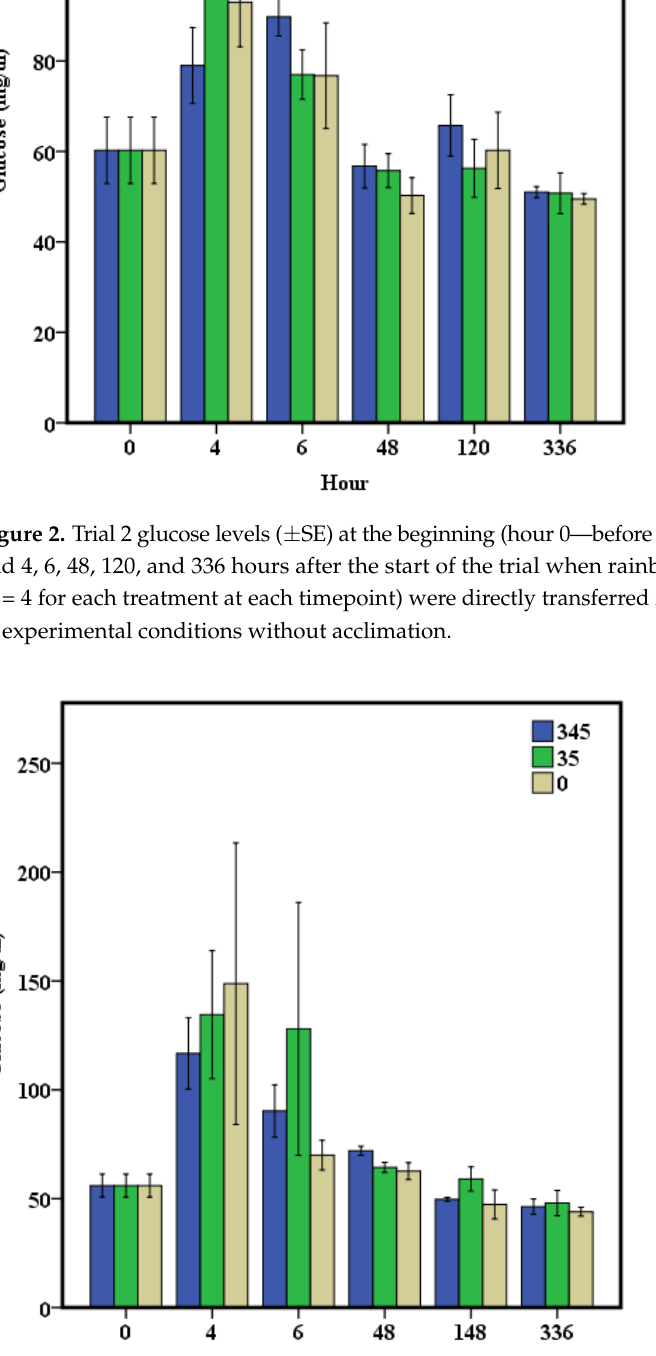
Figure 3. Trial 3 glucose levels ( ± SE) at the beginning (hour 0—before transfer, basal hardness of 345 mg/L) and 4, 6, 48, 120, and 336 hours after the start of the trial when rainbow trout Oncorhynchus mykiss ( n = 4 for each treatment at each timepoint) were directly transferred from 345 mg/L water hardness to experimental conditions without acclimation. With blood glucose in the fourth trial, there was a significant interaction between hardness and temperature for hour 48 ( p = 0.046) and hour 168 ( p = 0.008) (Figure 4). Subsequent analysis using a one-way ANOVA indicated a significant difference in blood glucose at hour 48 between the fish at 0 mg/L hardness and 11 °C (65.75 mg/dL) and fish at 345 mg/L and 20 °C (53.25 mg/dL). Similarly, on hour 168, glucose was significantly different between the fish in the 0 mg/L hardness and 20 °C treatment (48.75 mg/dL) compared to the fish in the 345 mg/L hardness and 20 °C treatment (58.25 mg/dL). However, all glucose values were relatively close to the basal level of 57.75 mg/dL. By the end of the trial (14-days), all glucose values were below basal.